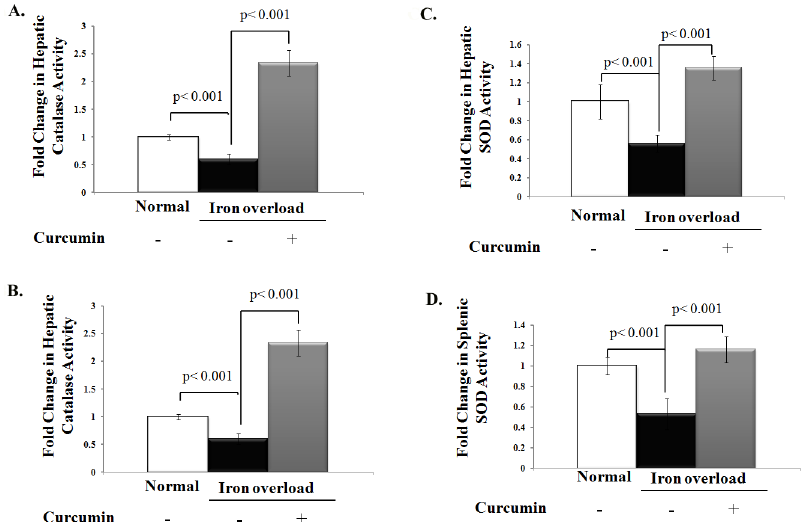
Fig 4. Curcumin boosts activities of endogenous enzymatic antioxidants that were depleted with chronic iron overload. A, B) Fold change in catalase (CAT) activity (U/g tissue) in liver and spleen relative to that of normal control, which was assigned a value of 1; C, D) Fold change in Superoxide dismutase (SOD) activity (U/g tissue) in liver and spleen relative to that of normal control which was assigned a value of 1. Activities of CAT and SOD in these tissues were significantly decreased in iron overloaded rats than controls. Curcumin treatment significantly boosted activities of both CAT and SOD in iron overloaded rats even to higher levels than those of control rats. Data shown are the mean ± SD (n = 5).